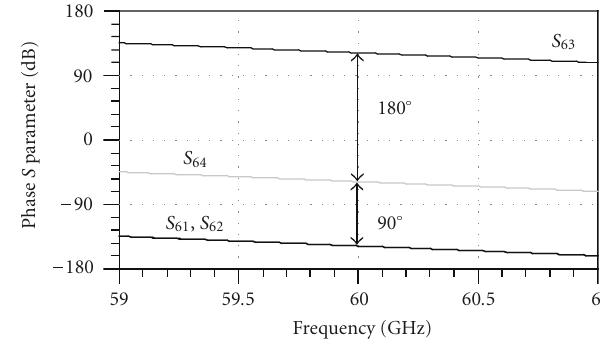
Figure 6: Simulation results of the transmission S parameter phase corresponding to the RF input.